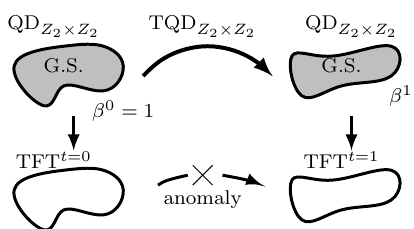
Figure 4. Stand-alone (1 + 1)-D theories de(cid:12)ned by (cid:12) 0 and (cid:12) 1 cannot be continuously connected. Upon a transition point during the deformation from TFT t =0 to TFT t =1 , the system is gapless, and the corresponding (1 + 1)-D theory is anomalous. This anomaly is canceled when (cid:12) 0 and (cid:12) 1 de(cid:12)ne two boundaries of the same (2 + 1)-D